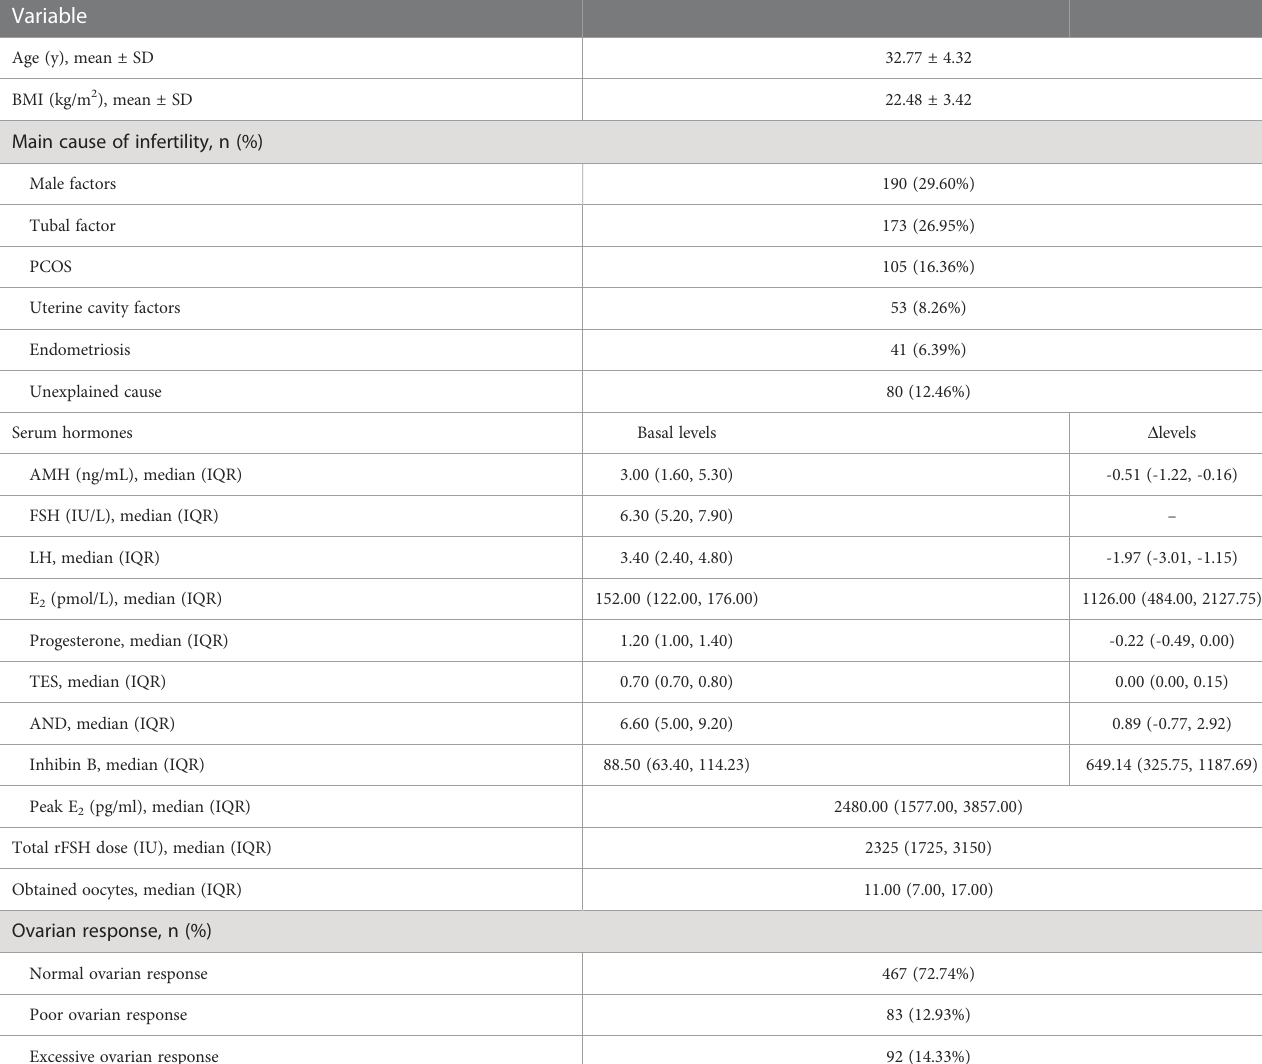
TABLE 1 Clinical characteristics of 642 IVF cycles of standard GnRH antagonist ovarian stimulation.